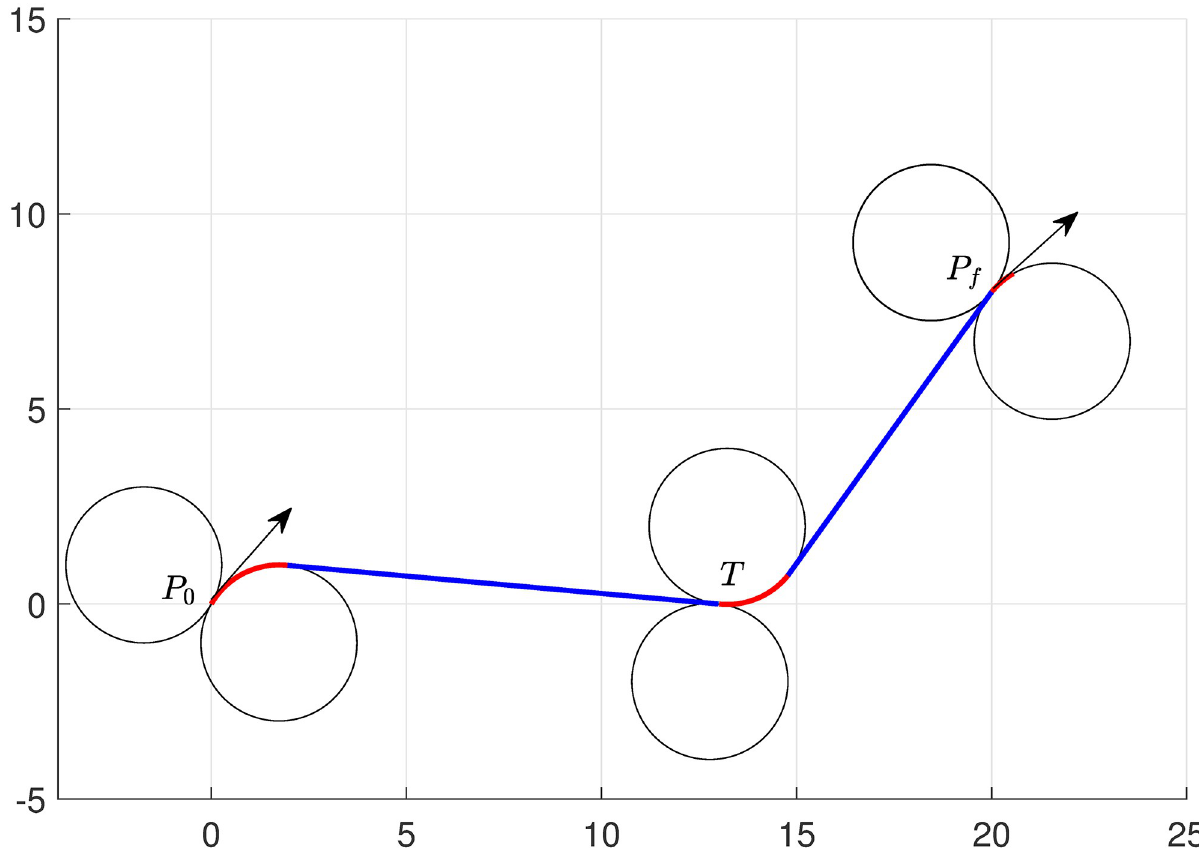
Fig 7. Shortest path generated by the model [9, Section 5.1, Problem (Ps)].